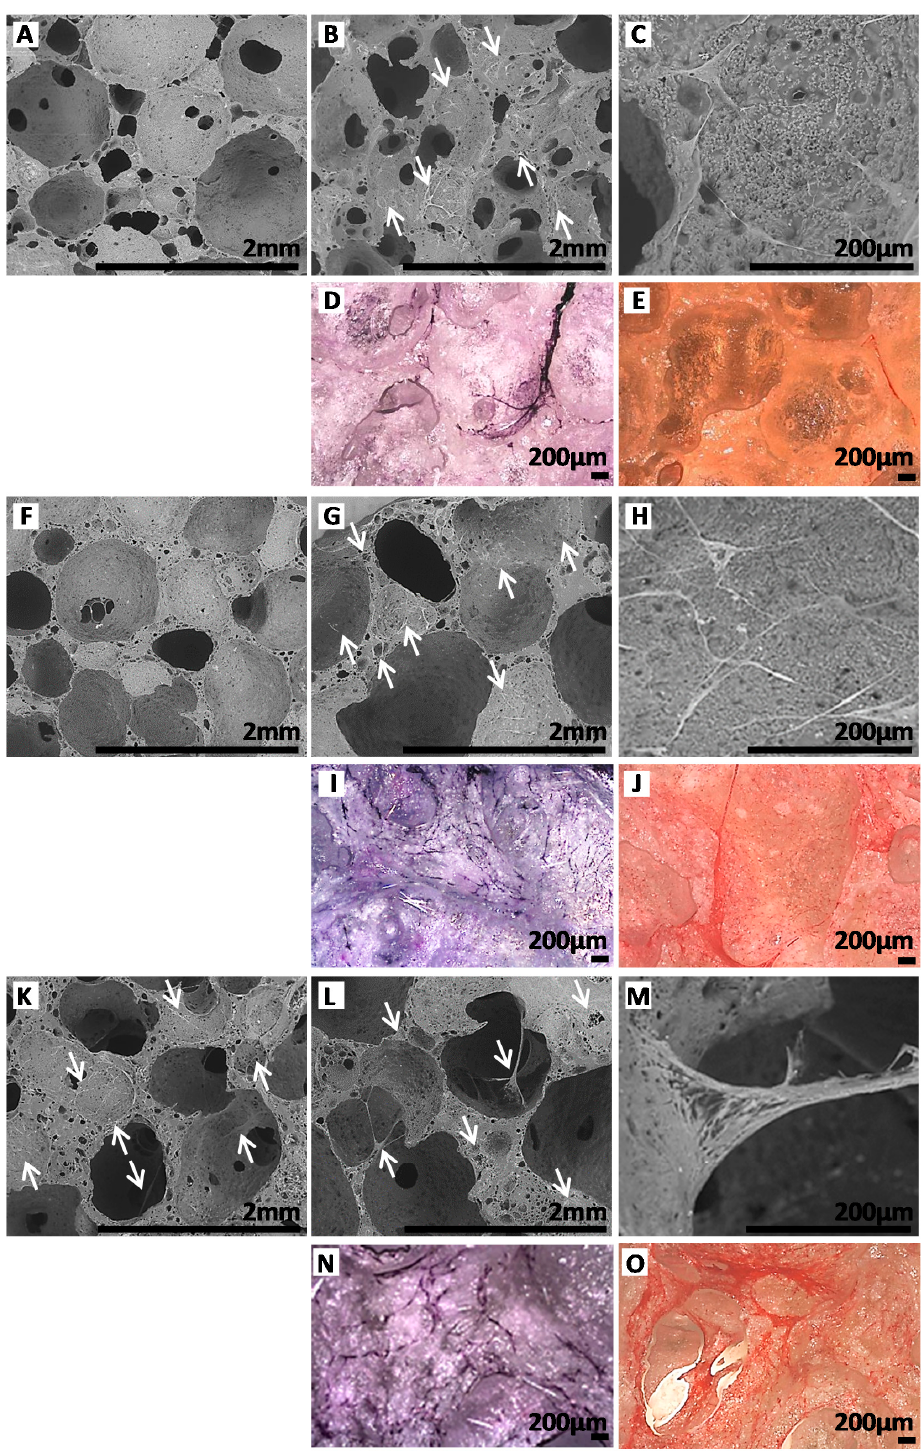
Figure 9. ESEM images of sca ff olds after 10 ( A , F , K ) and 35 ( B , C , G , H , L ,M) days of fibroblast migration (Arrows indicate some locations of cells in ESEM images). Images after 35 days of fibroblast migration of sca ff olds stained with Hemalun ( D , I , N ) and Sirius red ( E , J , O ). A , B , C , D , E : Non-functionalized sca ff olds synthesized in absence of fucoidan and impregnated with PRP. F , G , H , I , J : PEUUF sca ff olds. K , L , M , N , O : PRP-PEUUF sca ff olds. (The LMW fucoidan concentration in the aqueous phase of the HIPE used for functionalization = 10 mg mL − 1 ; while the PRP concentration used for bio-activation = 15 vol% (16 h of